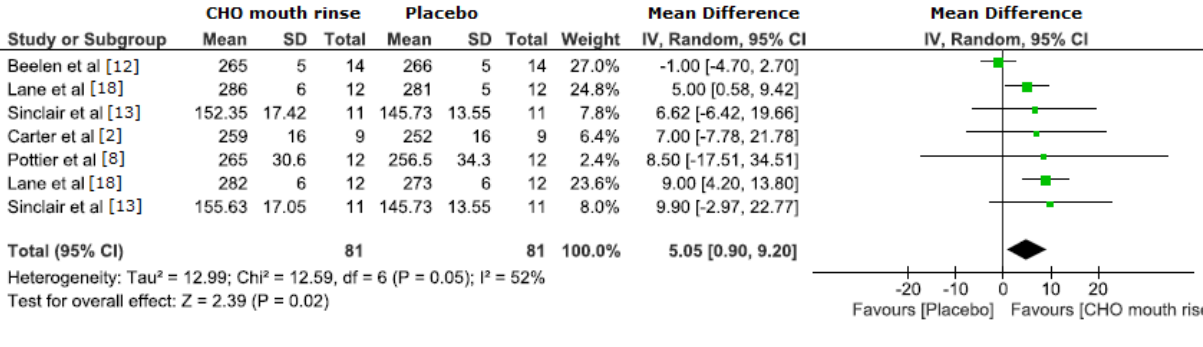
Figure 1. The overall effect of CHO mouth rinse on power output (W) as the main performance